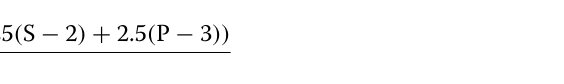
Table 1. The output of the Kappa coefficient for accuracy analysis showed a good value of 0.85 and total accuracy of around 88%. Formulas of the Kappa coefficient and total accuracy are shown in Eqs. 7–8: